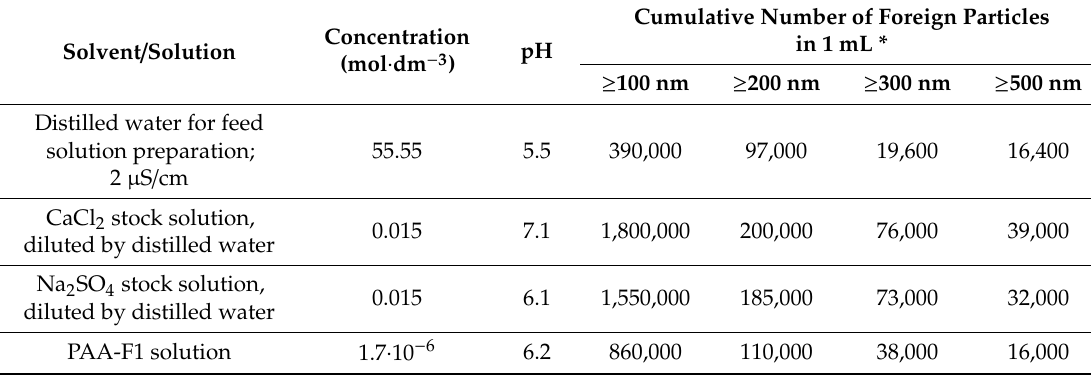
Table 1. Initial stock solutions characterization by particle